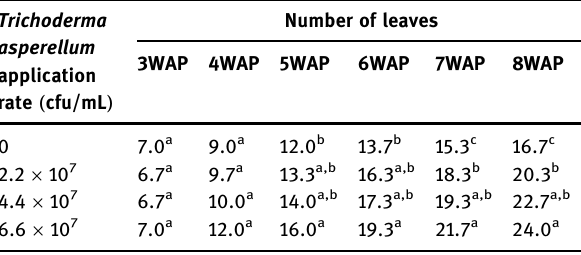
Table 3: E ff ect of Trichoderma asperellum on the number of leaves of Celosia argentea infected with Meloidogyne incognita Trichoderma asperellum application